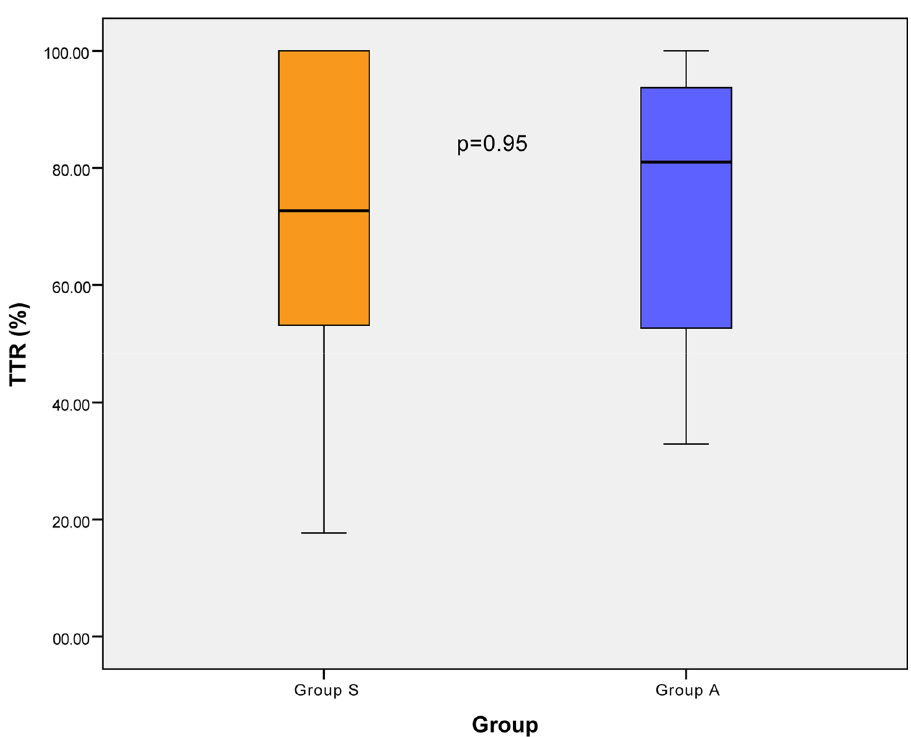
Figure 2. Box-and-Whisker plot of the time in therapeutic